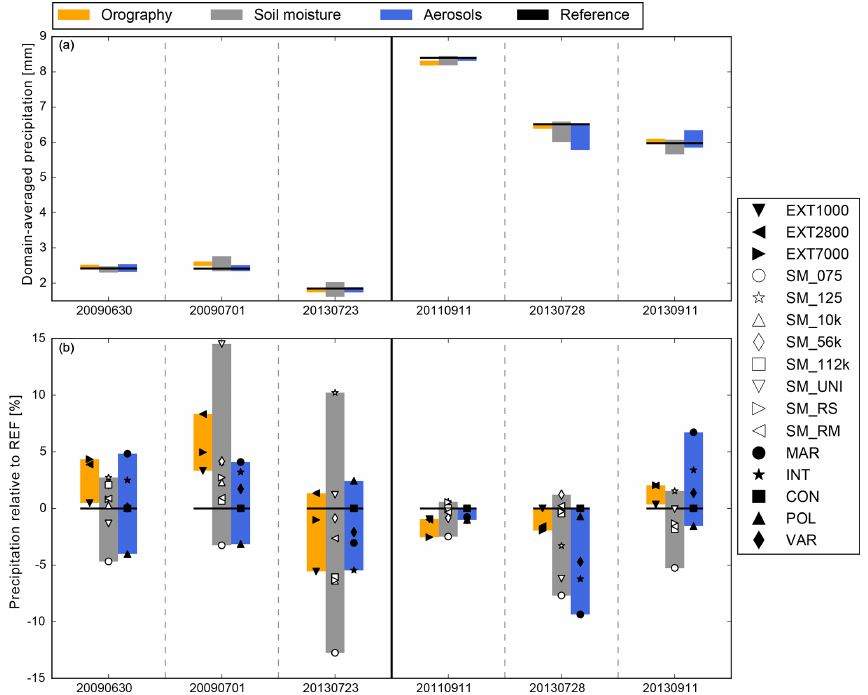
Figure 4. 24h domain-averaged precipitation (a) and deviation from the respective reference run (b) for the 6 days of investigation. The symbols denote the precipitation deviation and the height of the bar shows the distance between minimum and maximum mean precipitation for each set of